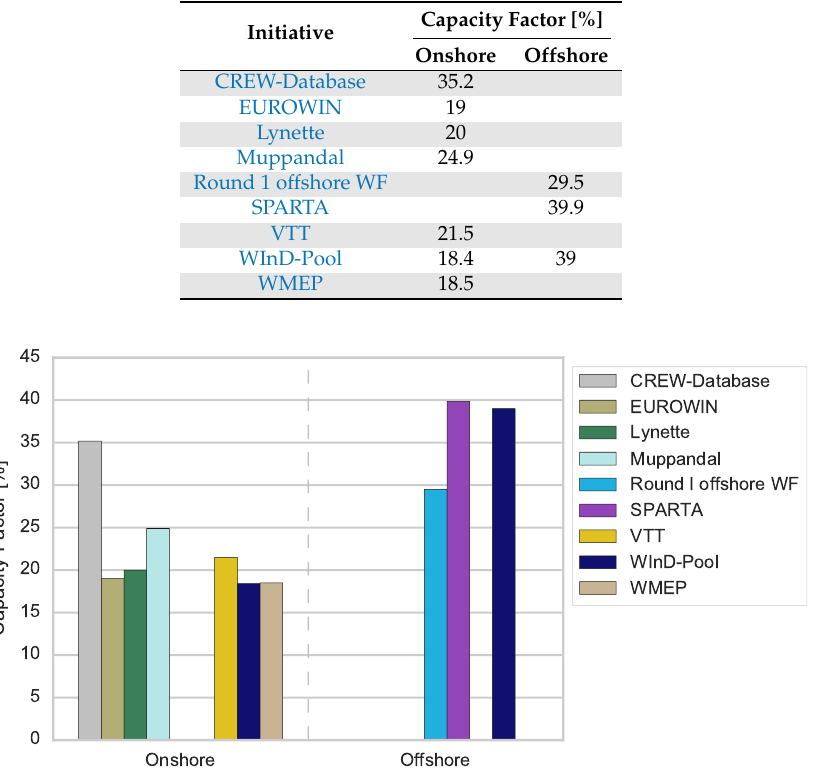
Table 2. Capacity factors of onshore and offshore WT as published by different initiatives.